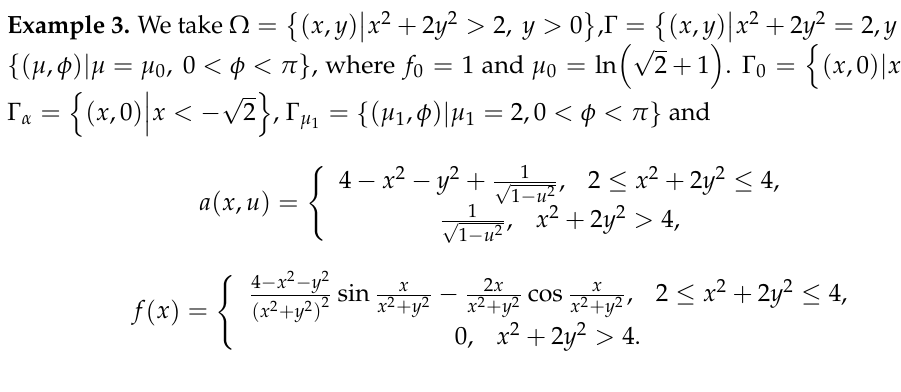
Figure 8. L ∞ ( Ω i ) errors against µ 1 for Example 2 ( N = 20 ) Figure 8. 𝐿 (cid:2998) (Ω (cid:3036) ) errors against 𝜇 (cid:2869) for Example 2 (𝑁 = 20) . Figure 8. 𝐿 (cid:2998) (Ω (cid:3036) ) errors against 𝜇 (cid:2869) for Example 2 (𝑁 = 20) .